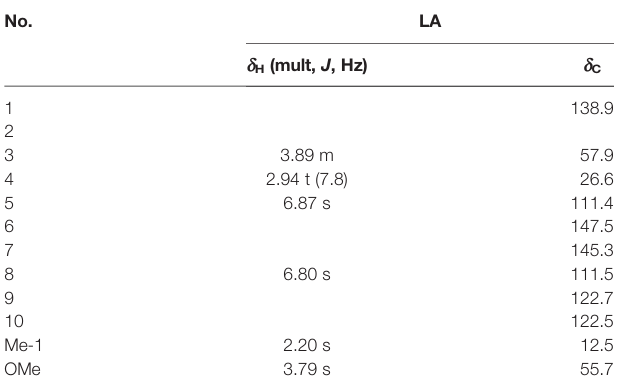
TABLE 1 | NMR data ( d ) for compound LA in MeOD a